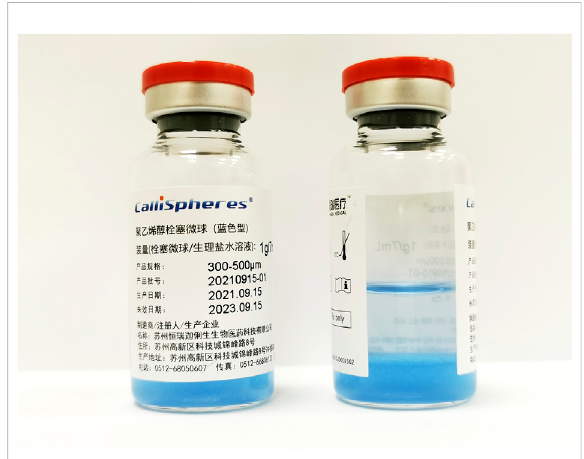
FIGURE 1 Photograph of CalliSpheres beads. It is a blue polyvinyl alcohol particles beads with a smooth surface, uniform size, and usually100 – 300 μ m or 300 – 500 μ m in diameter. About 7 ml of physiological sodium chloride solution and 2 ml beads were kept in bottles with no pharmacological